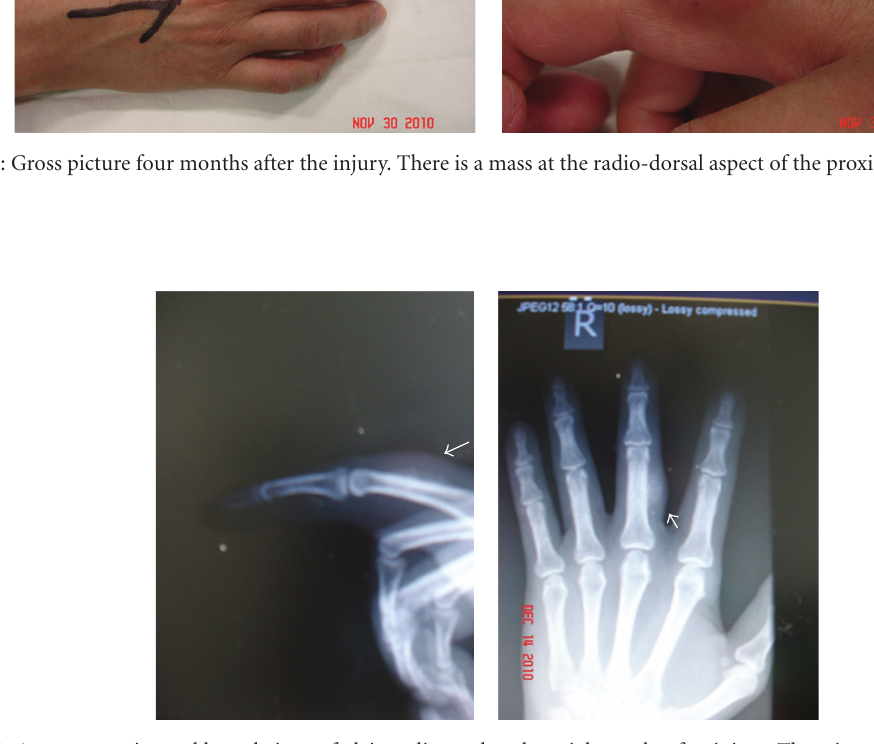
Figure 3: Anteroposterior and lateral views of plain radiographs taken eight weeks after injury. There is a calcified bony